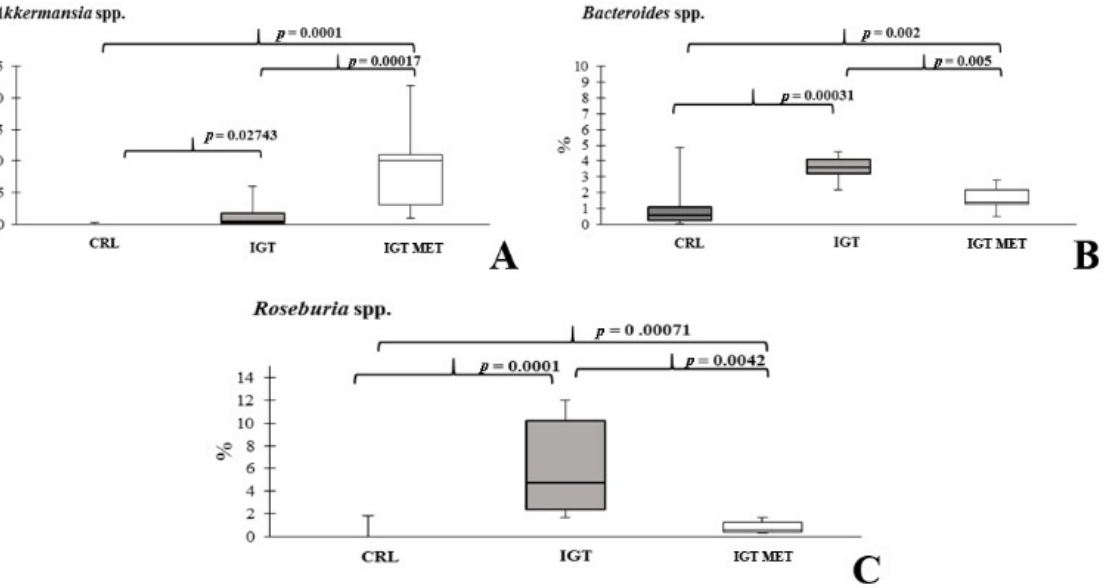
Figure 8. Relative abundances of genera Akkermansia ( A ), Bacteroides ( B ), and Roseburia ( C ) in the fecal samples of rats from different groups. CRL—control group, IGT—impaired glucose tolerance group, IGT MET—impaired glucose tolerance + metformin group.